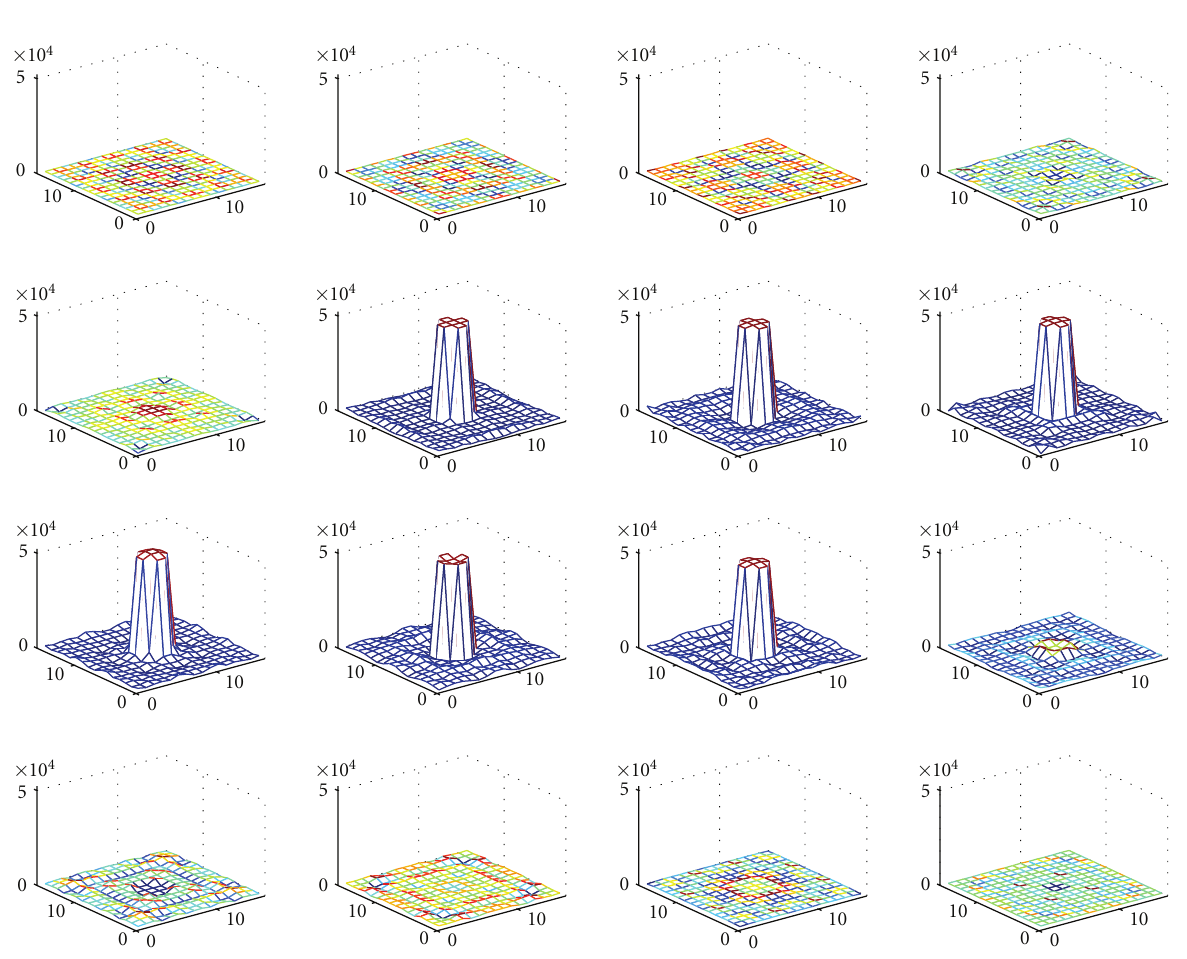
Figure 9: Reconstructed object in the absence of noise (RMSE = 1 . 2%) (reprinted with permission from [20]).